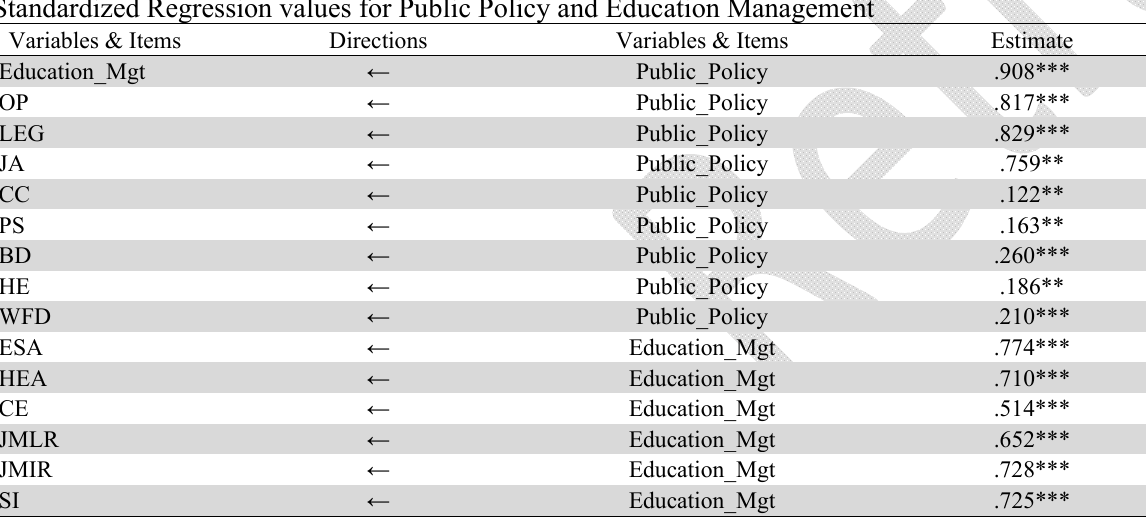
Standardized Regression values for Public Policy and Education